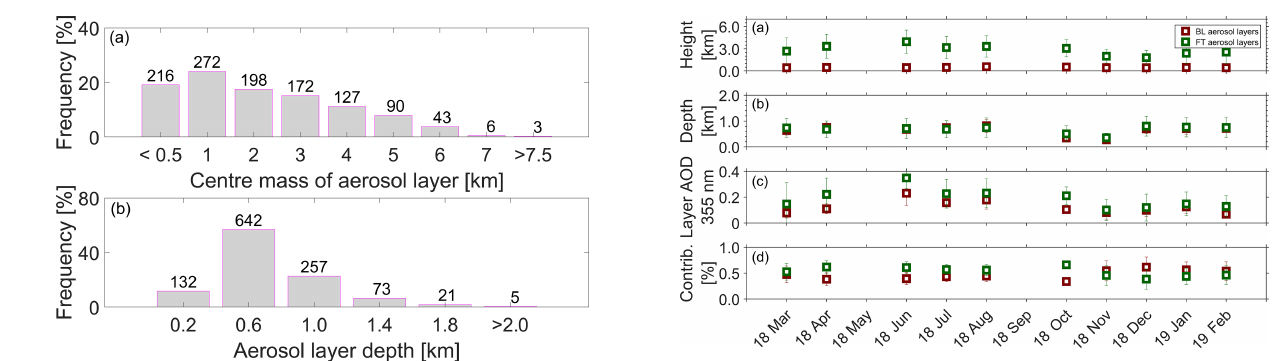
Figure 3. Geometrical characteristics of the aerosol layers during the campaign period. (a) Frequency of the altitude of the centre of mass of the aerosol layers. The width of each bin 1km apart from the first and last bins. (b) Frequency of the geometrical depth of the aerosol layers. The width of each bin is 0.4km apart from the last bin. The numbers on top of the bars indicate the number of cases included in the bin.